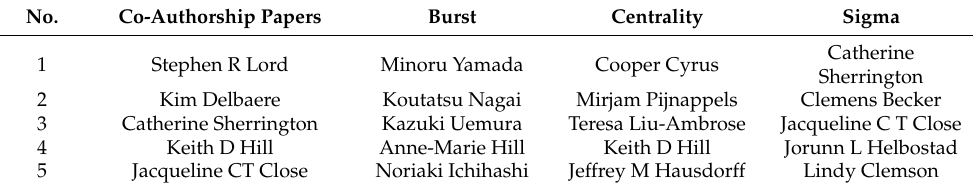
Table 2. Author rank in different